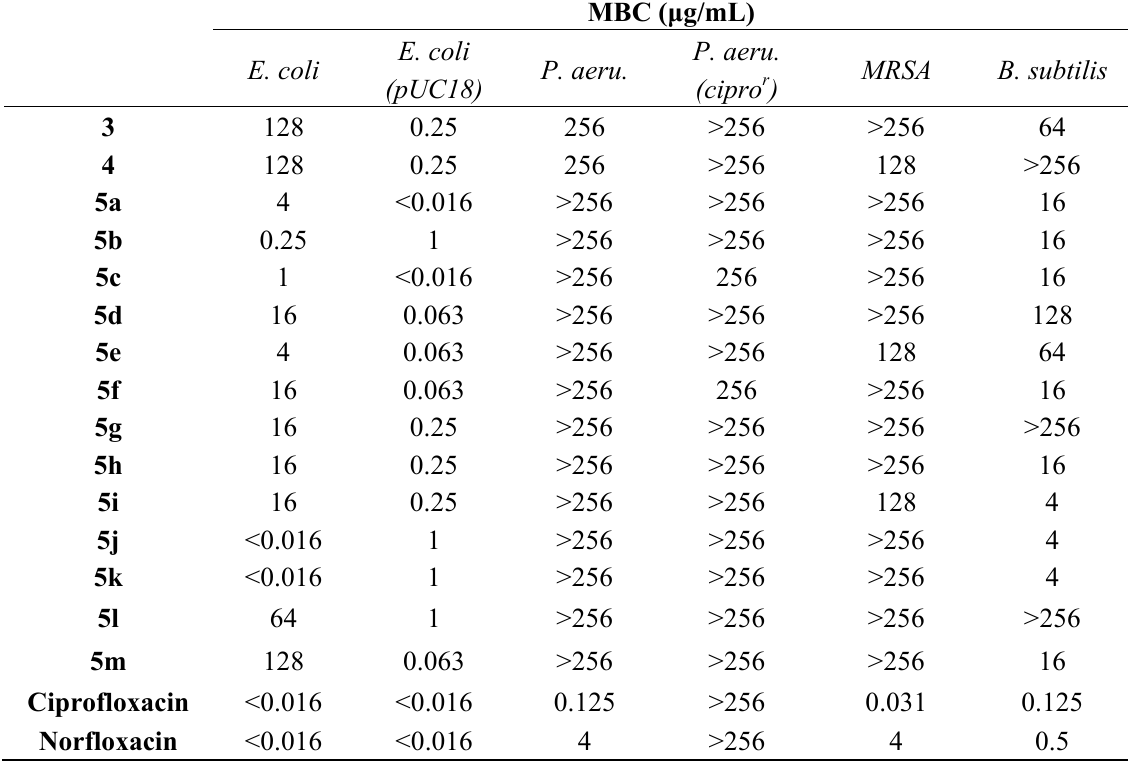
Table 3. In vitro MBC values of ciprofloxacin derivatives against certain G(+)- and